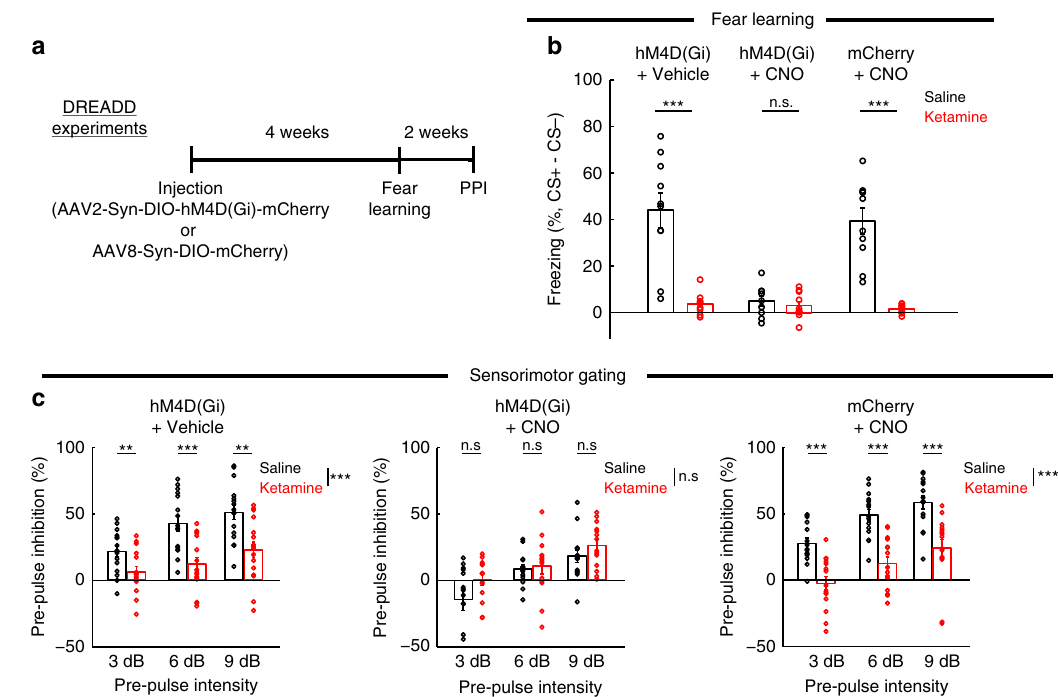
Fig. 7 Acute suppression of SST interneuron activity in Cg1/M2 occludes the behavioral effects of ketamine. a Timeline for experiments involving use of Cre-dependent expression of designer receptors exclusively activated by designer drugs (DREADD) in SST-IRES-Cre animals. b Fraction of time spent freezing during CS + and trace period, subtracted by that during CS − and trace period on the testing day. For hM4D(Gi) + Vehicle condition, ketamine (10 mg/kg) treatment caused an impairment in freezing compared to saline (saline: 44 ± 7%, ketamine: 4 ± 2%, mean ± s.e.m.; P = 2 × 10 − 4 , Wilcoxon rank-sum test; n = 10 animals for saline and 9 for ketamine). For hM4D(Gi) + CNO condition, there was impairment in freezing in saline-treated animals with no further difference relative to ketamine-treated (10 mg/kg) animals (saline: 5 ± 2%, ketamine: 3 ± 2%, mean ± s.e.m.; P = 0.78, Wilcoxon rank-sum test; n = 9 animals for saline and 10 for ketamine). There was no effect of CNO on ketamine-induced (10 mg/kg) impairment as tested in the mCherry + CNO condition (saline: 39 ± 5%, ketamine: 1.5 ± 1%, mean ± s.e.m.; P = 2 × 10 − 4 , Wilcoxon rank-sum test; n = 10 animals each for saline and ketamine). c Pre-pulse inhibition as a measure of sensorimotor gating. For hM4D(Gi) + Vehicle condition, a two-way within-subjects ANOVA with pre-pulse